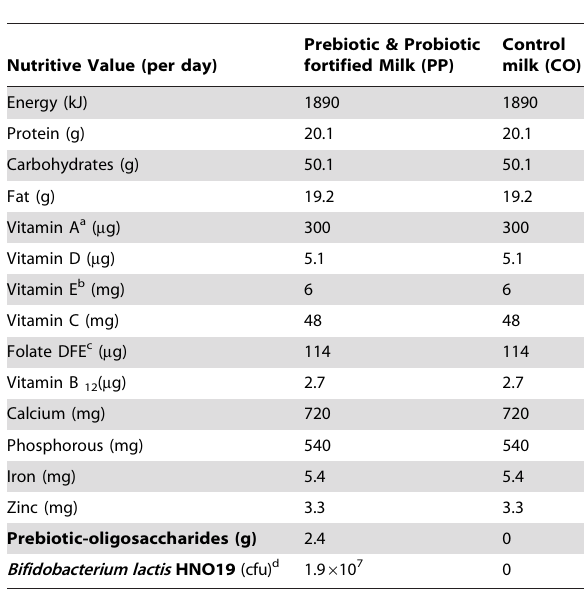
Table 1. Composition of prebiotic and probiotic fortified milk and control